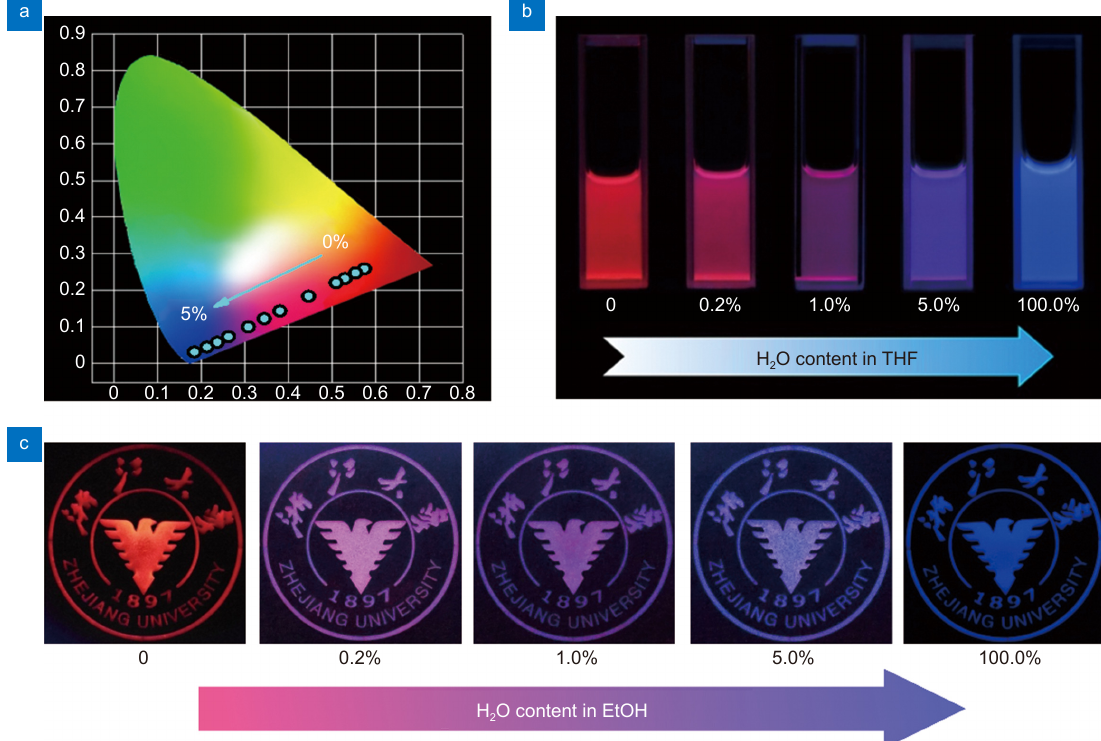
Fig. 5 | ( a ) CIE chromaticity coordinates of the luminescence color of Eu(BDC-NH 2 ) in THF with different water content ( c = 0, 0.01, 0.04, 0.1, 0.3, 0.5, 0.7, 1, 1.5, 2, 3, and 5 vol%, respectively). Photographs of Eu(BDC-NH 2 ) in ( b ) THF and ( c ) EtOH with different water content excited at 365